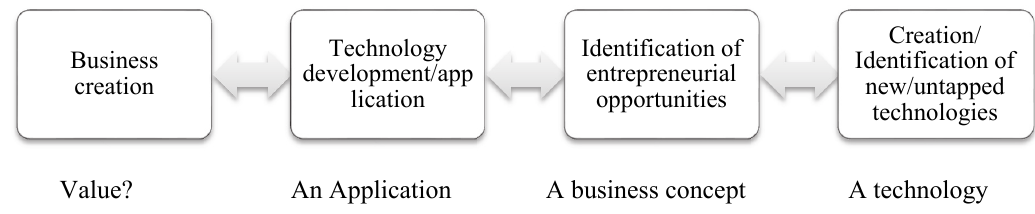
Fig. 1. A systematic approach to technological